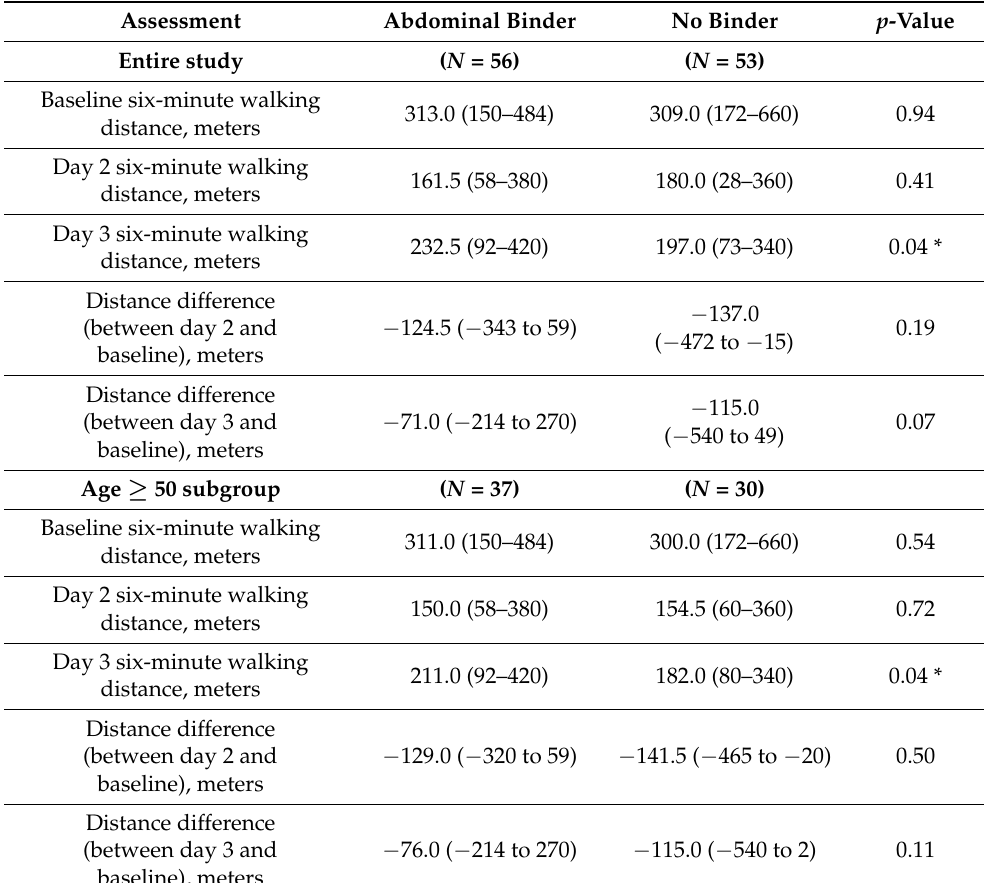
Table 4. Six-minute walk test